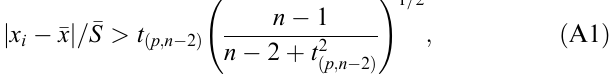
Table 7. Partial correlation coe(cid:129)cients calculated for set of data satisfying the condition of Eq. (13) j Dst j F 10.7 Kp R 2 I 1 0.56 (cid:139) 0.06